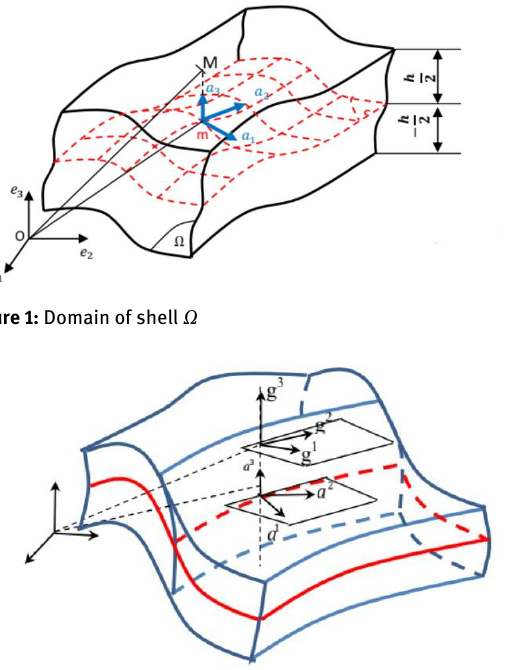
Figure 2: Local and membrane basis